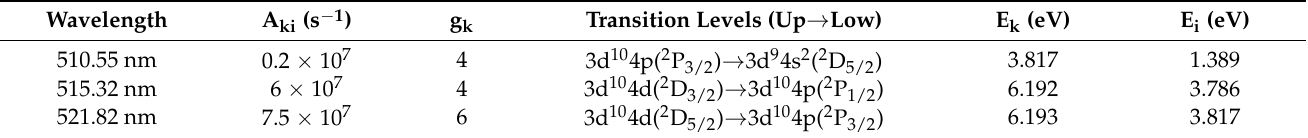
Table 1. Spectroscopic parameters of the Cu atomic lines.